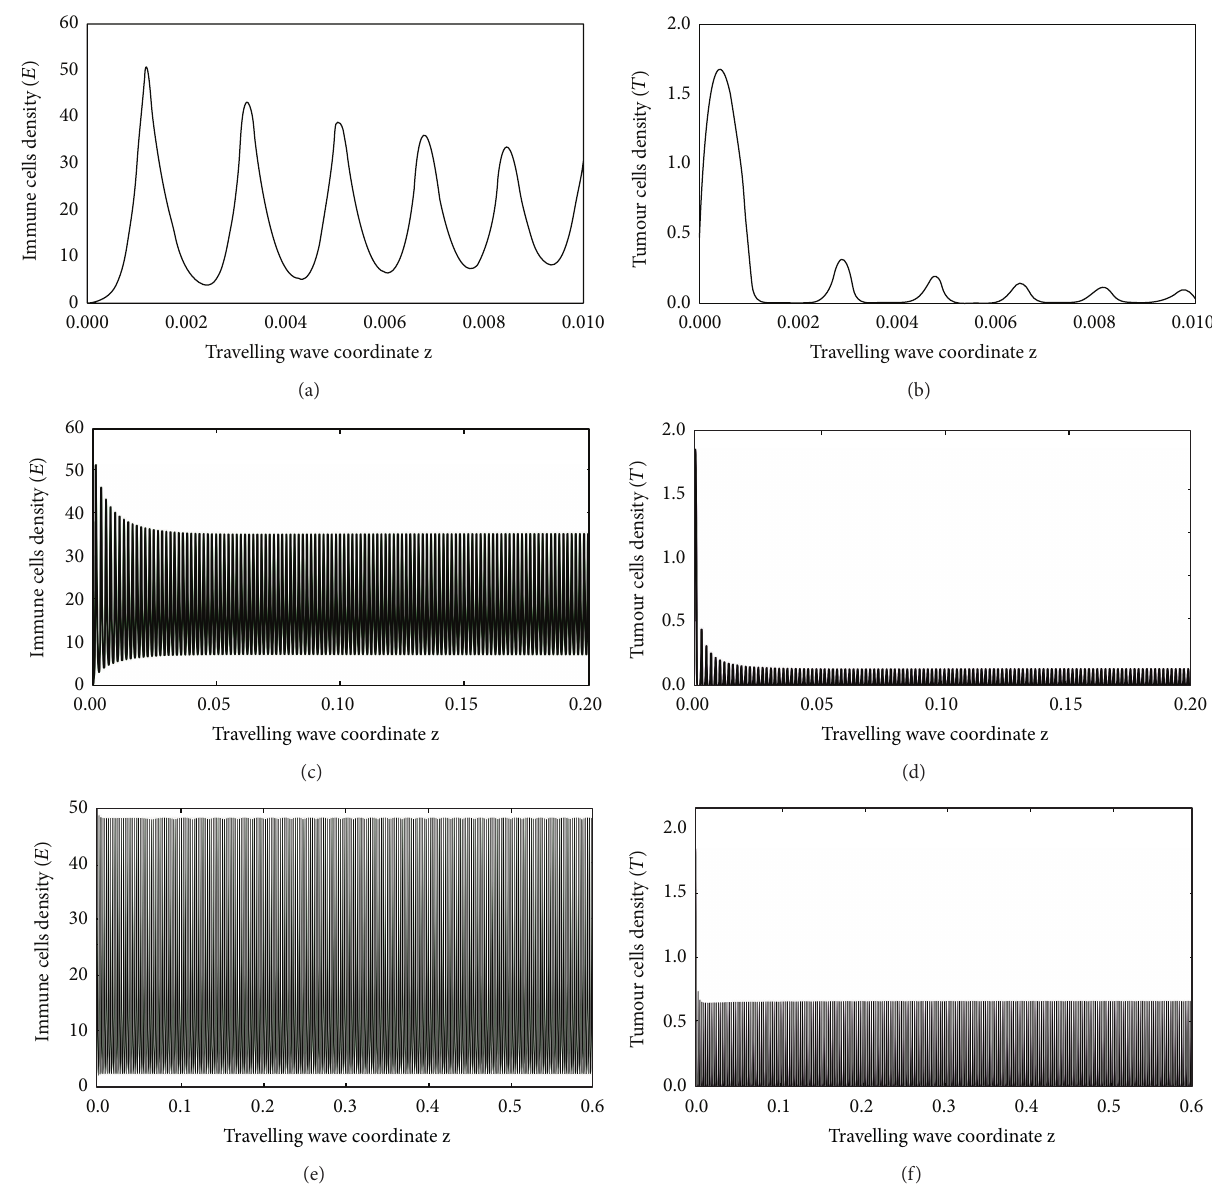
Figure 3: Travelling wave solutions of the system (3) for different travelling wave coordinates with